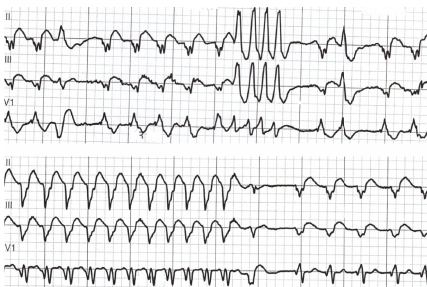
Figure 3: Nonsustained ventricular tachycardia on telemetry with two di ff erent